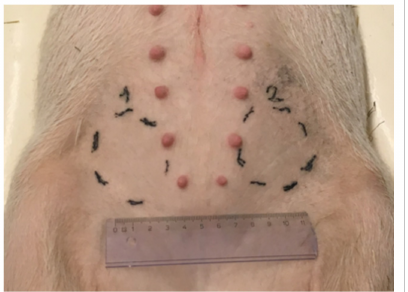
Figure 6. Marking of injection sites in the plica inguinalis of a minipig. Animals were randomized in 2 groups of 4